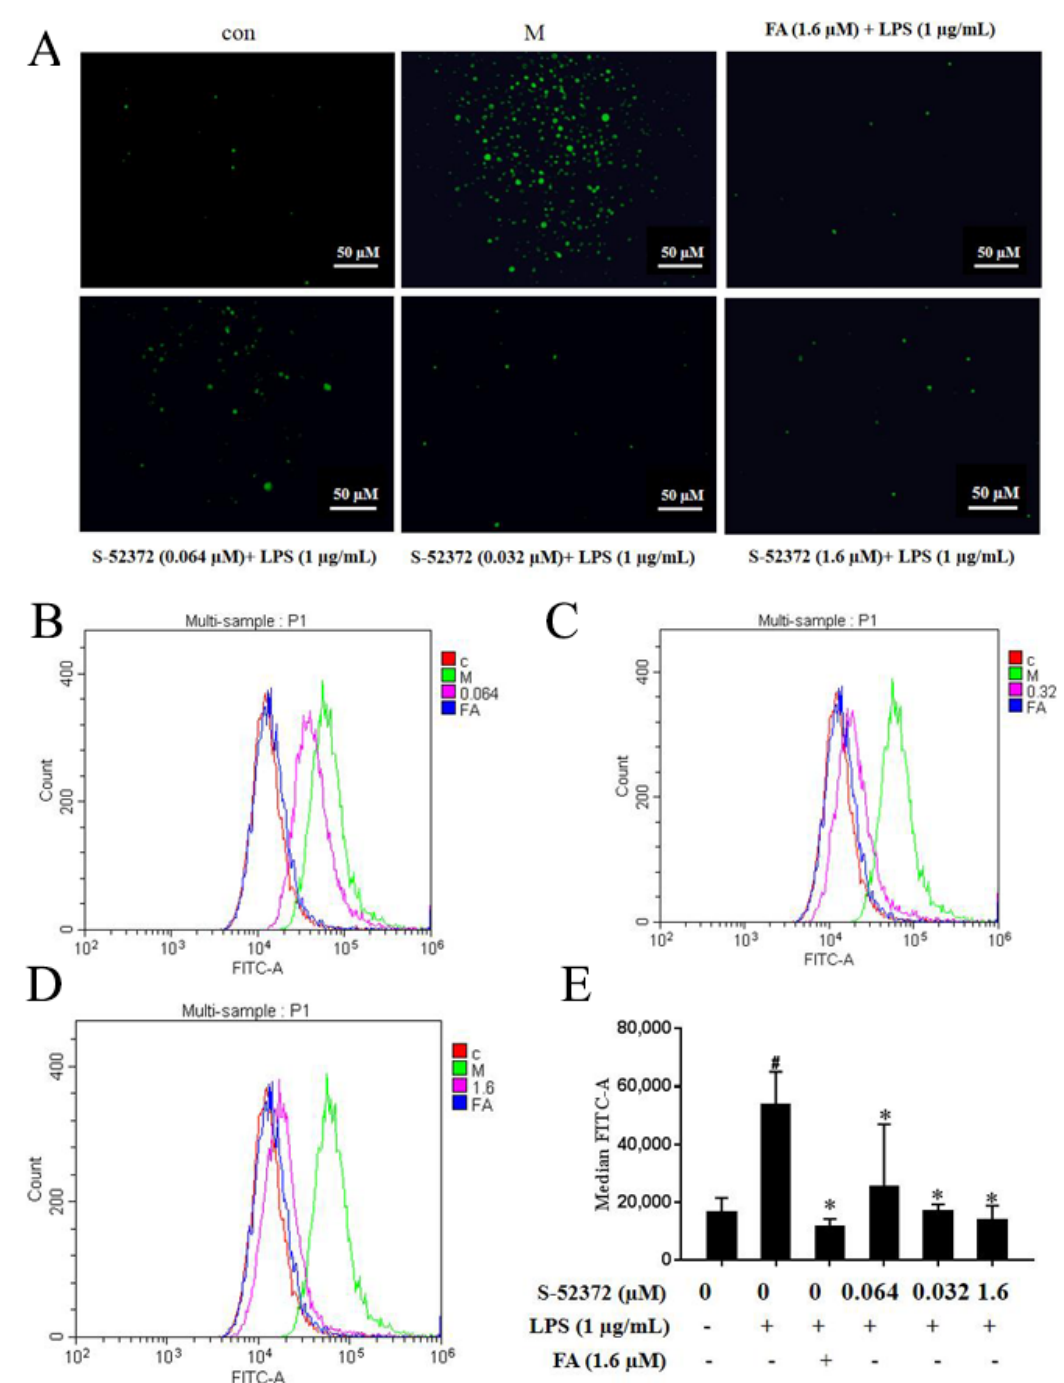
Figure 9. Ferulic acid and its derivative, S-52372, inhibited LPS − induced intracellular ROS production. In addition to an untreated control sample, RAW264.7 cells were pretreated with 1.6 µ mol/L of FA as a positive control to compare with RAW264.7 cells pretreated with with S-52372 at 1.6, 0.32, and 0.064 µ M for 1.5 h, and then all groups were treated with 1 µ g/mL of LPS, except the control group, at 37 ◦ C for 24 h. ( A ) ROS fluorescence images of FA (1.6 µ M) and S-52372 (1.6, 0.32, and 0.064 µ M). ( B ) ROS production at 0.064 µ M of S-52372 to compare with FA at 1.6 µ M. ( C ) ROS production at 0.32 µ M of S-52372 to compare with FA at 1.6 µ M. ( D ) ROS production at 1.6 µ M of S-52372 to compare with FA at 1.6 µ M. The results were presented in the above superposition of the fluorescence spectra of all groups. ( E ) Relative fluorescence intensity analysis. * p < 0.05 compared to the only LPS − -treated group; # p < 0.05 compared to the control group.